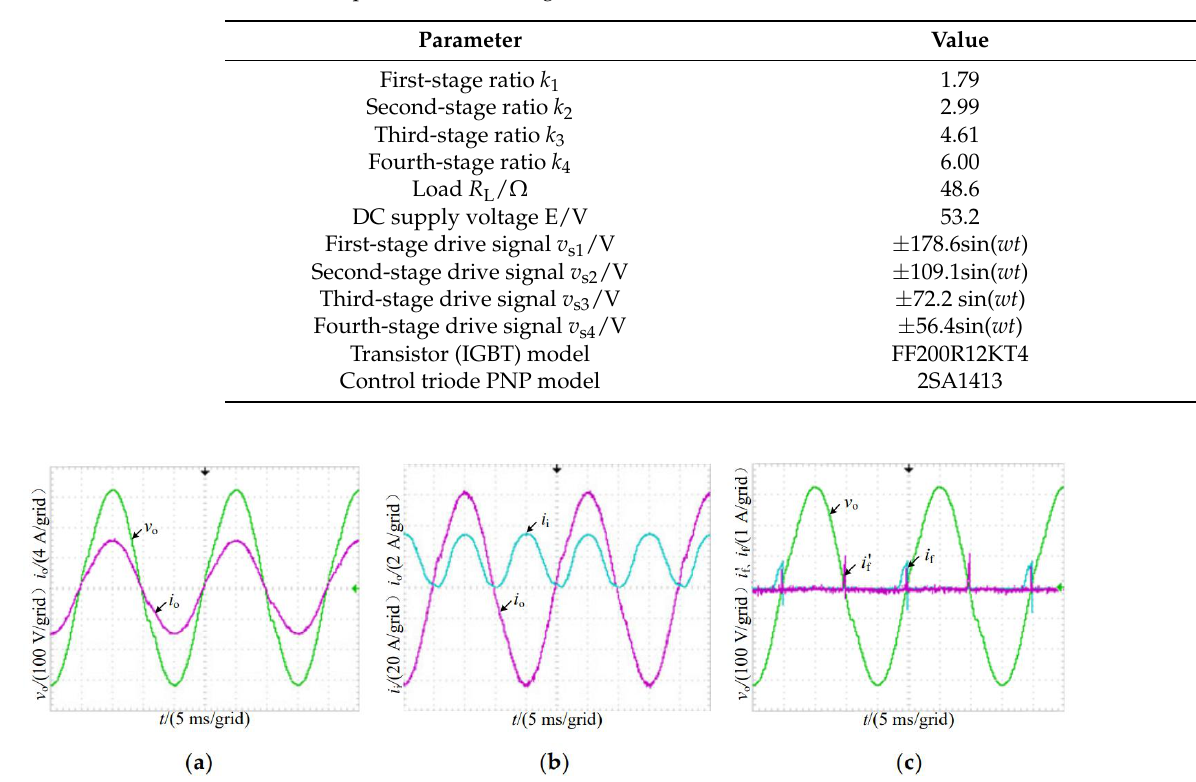
Figure 9. Output waveform of 4-stage HDCPLN. ( a ) Load voltage and current waveform. ( b ) Primary and secondary total current. ( c ) No-load voltage, excitation current.